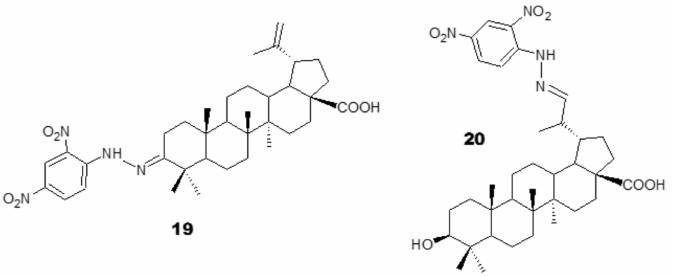
Figure 5. 2,4-Dinitrophenyl-hydrazone-BA analogues with moderate antiplasmodial activity.